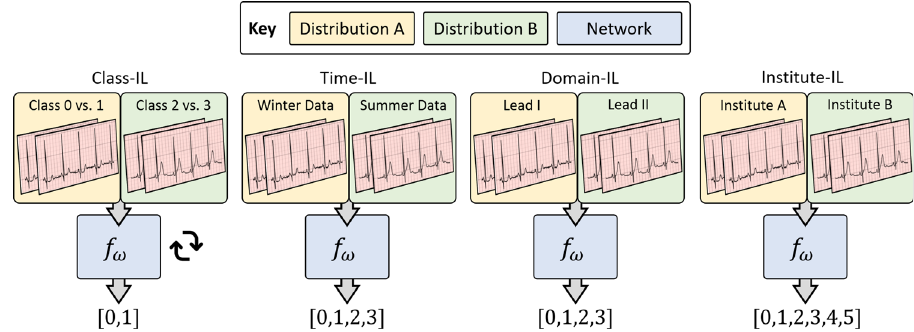
Fig. 1 Four continual learning scenarios. A deep-learning system, f ω , is sequentially exposed to tasks with potential data distribution shifts. In the Class-IL scenario, we present mutually exclusive pairs of classes to re fl ect novel diseases. In the Time-IL scenario, we present data collected at different times of the year to re fl ect temporal non-stationarity. In the Domain-IL scenario, we present data from different input modalities to re fl ect different physiological sensors. In the Institute-IL scenario, we present completely different datasets to re fl ect disparate healthcare institutions. The system in the Class-IL scenario has a classi fi cation head that is speci fi c to the task, and is thus task-speci fi c. In the remaining scenarios, the system is task-agnostic; it is not aware of the task identity of